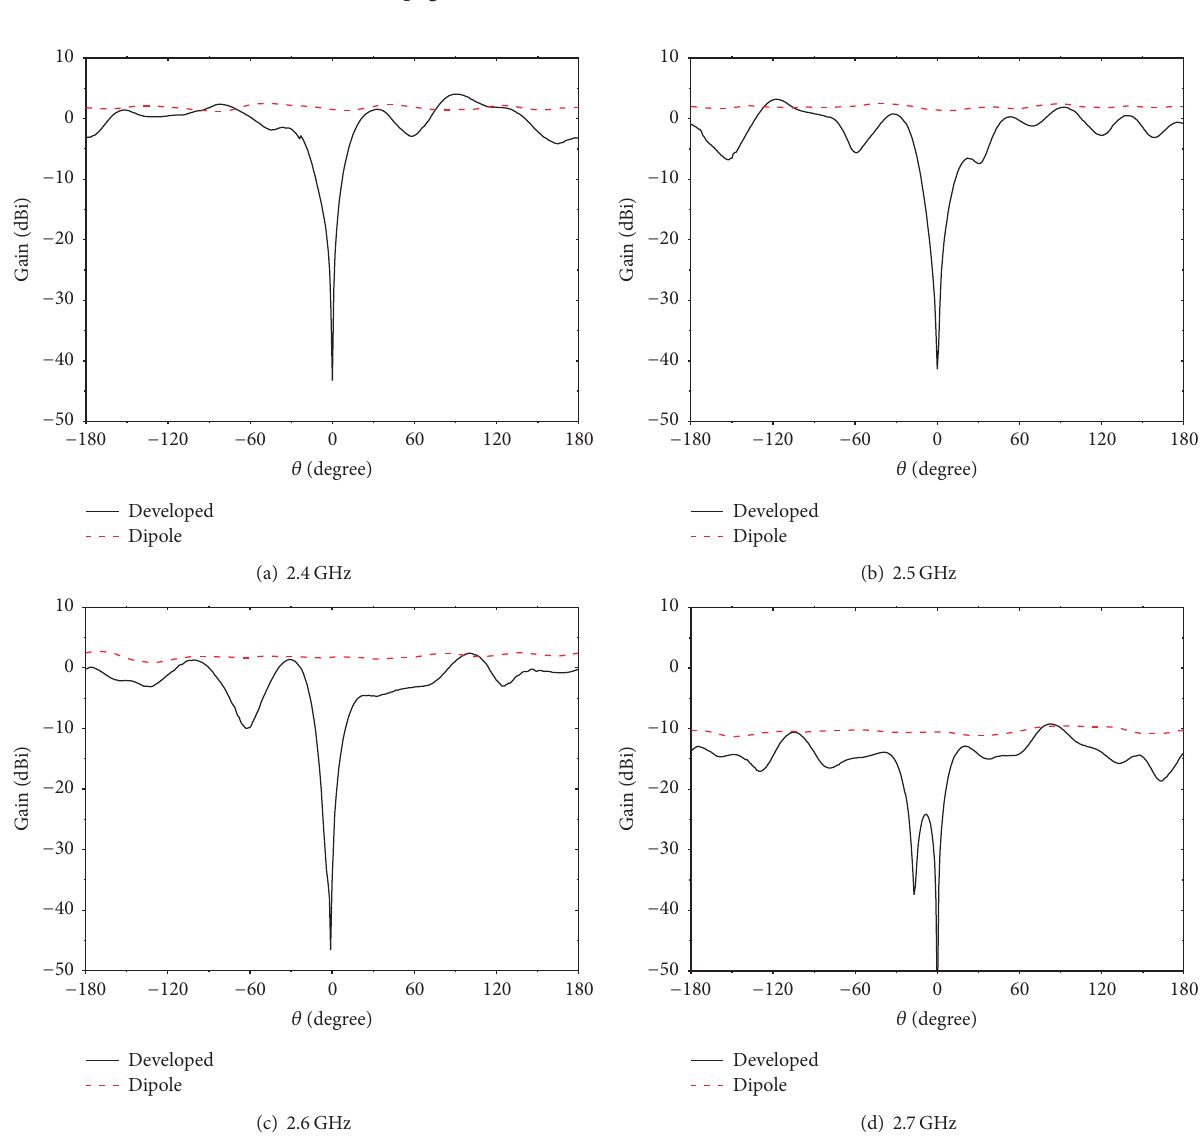
Figure 16: Nulling mode radiation patterns of the developed antenna from 2.4 GHz to 2.7